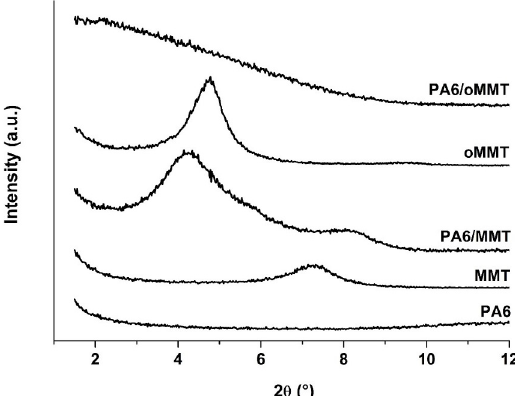
Figure 1. WAXD diffractograms of the PA6, nanoparticles and nanocomposites obtained by twin-screw extrusion.